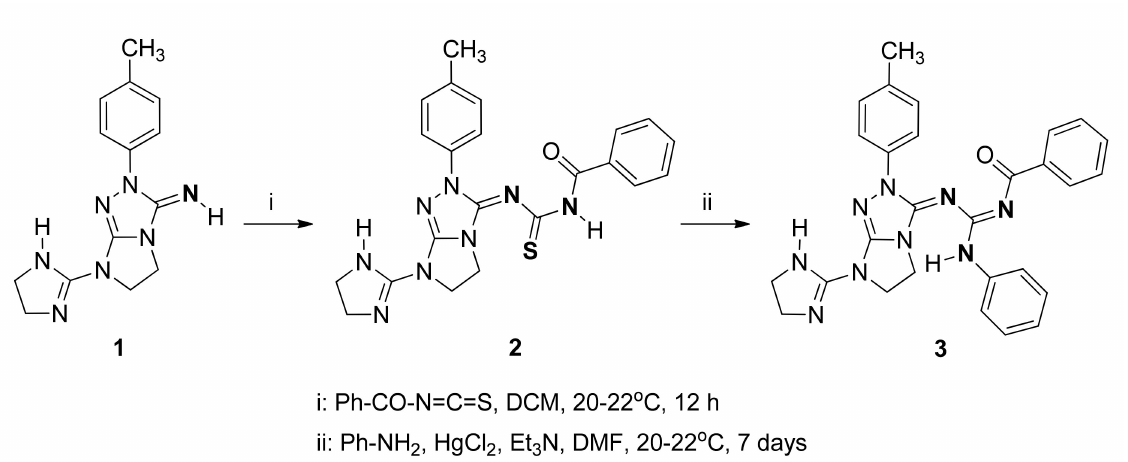
Scheme 1. Synthesis of guanidine derivative 3